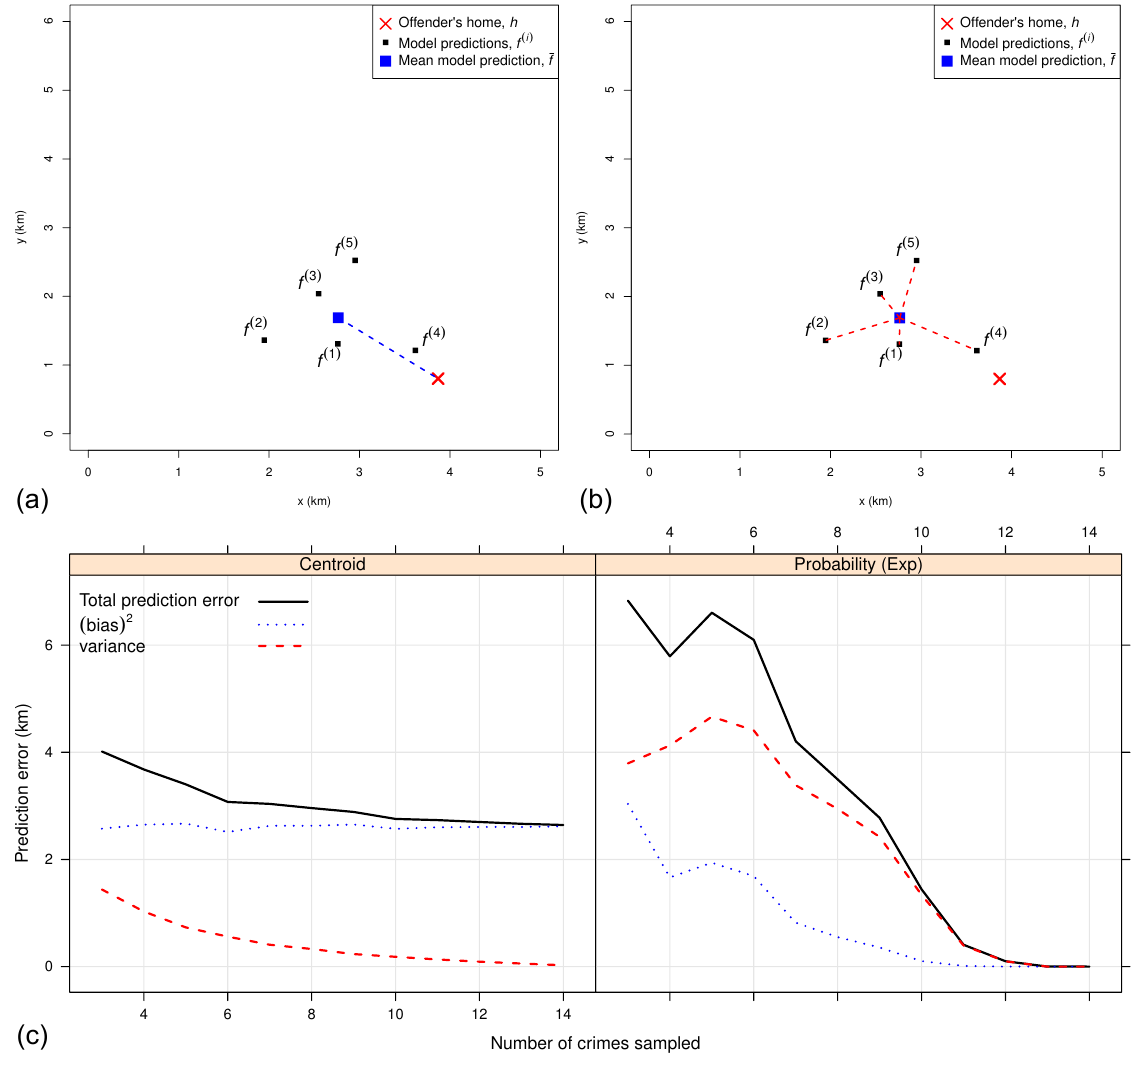
Figure 2 Panels (a) and (b) illustrate the calculation of bias and variance for an ensemble of 5 predictions, f (1) , . . . , f (5) . Bias, shown in (a), is the difference between the mean prediction of the ensemble, ¯f , shown as a blue square, and the true home location of the offender, h , shown using a red cross. Variance, shown in (b), is variation among the individual members of ensemble relative to the mean prediction. Panel (c) decomposes prediction errors of the model comparison shown in Figure 1(d) into bias and